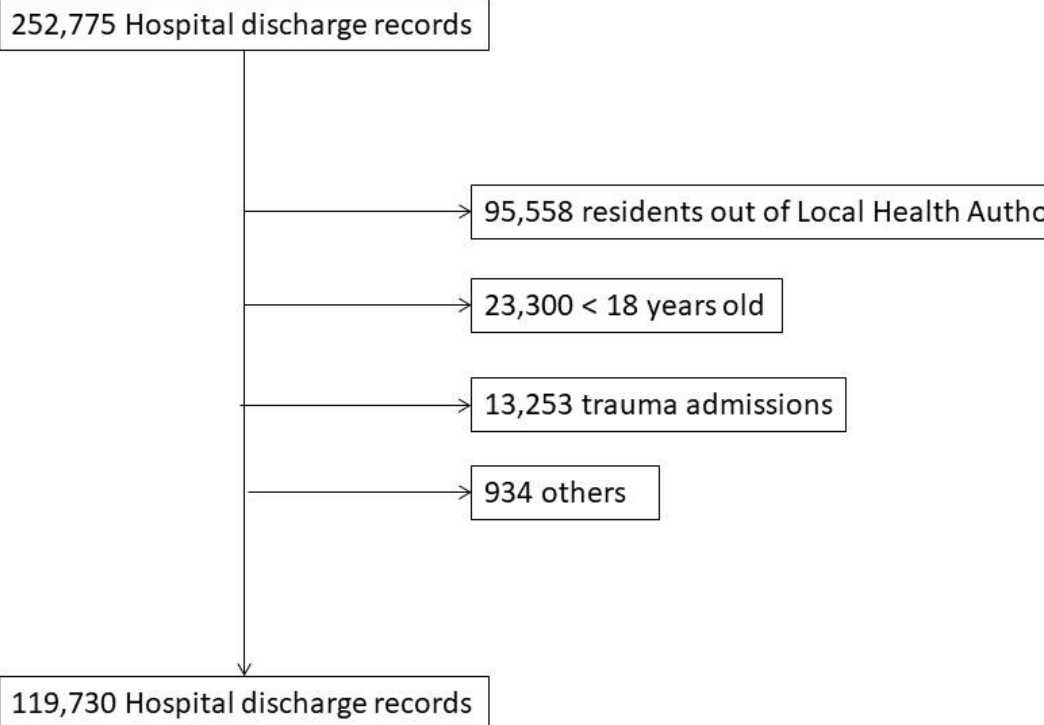
Figure 1. Flow chart of included